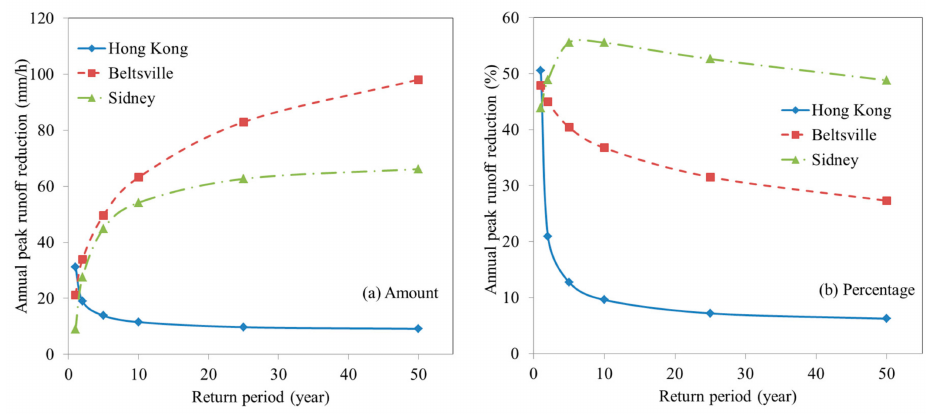
Figure 4. Annual peak runo ff reduction during storms with di ff erent return periods, given in terms of ( a ) amount and ( b ) percentage.